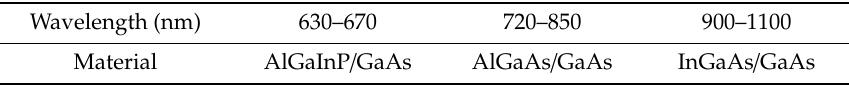
Table 4. Summary of the materials used to design LDs with di ff erent wavelengths.